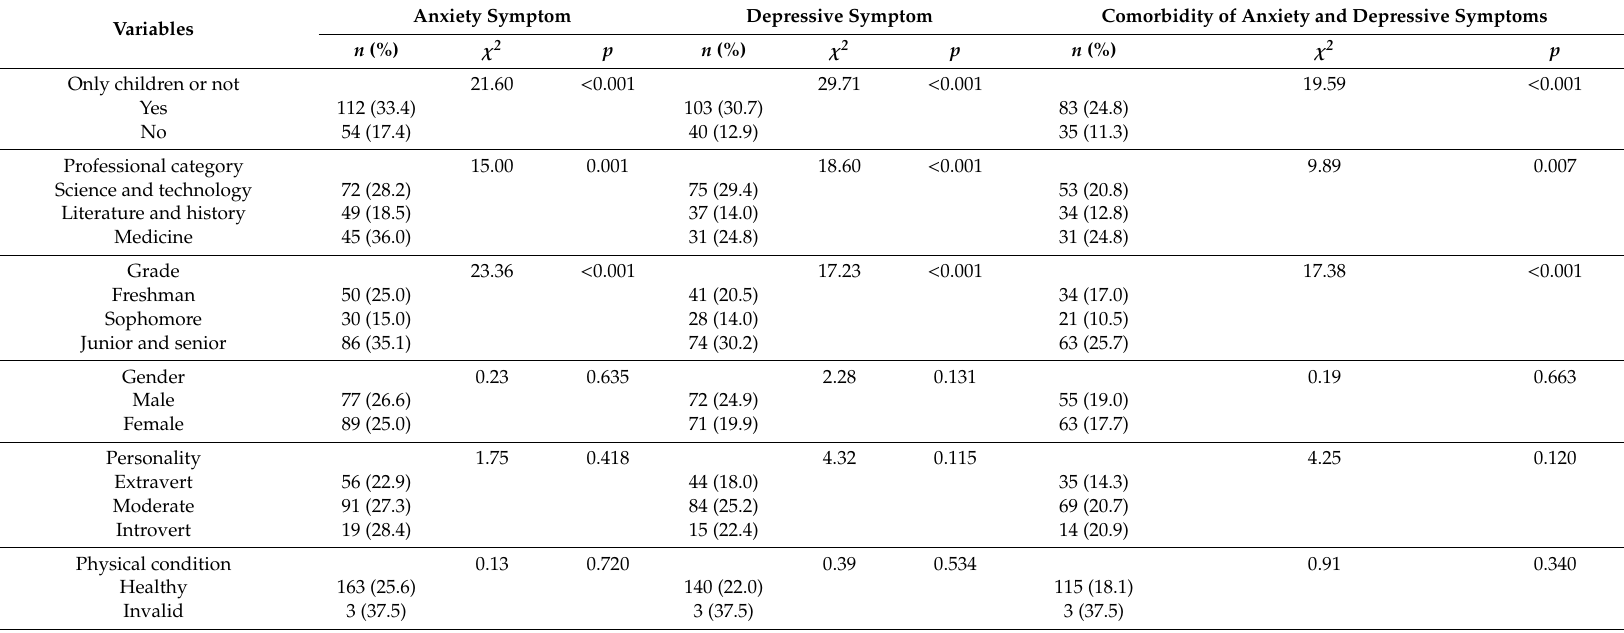
Table 2. Univariate analysis of associated factors of anxiety and depressive symptoms among college